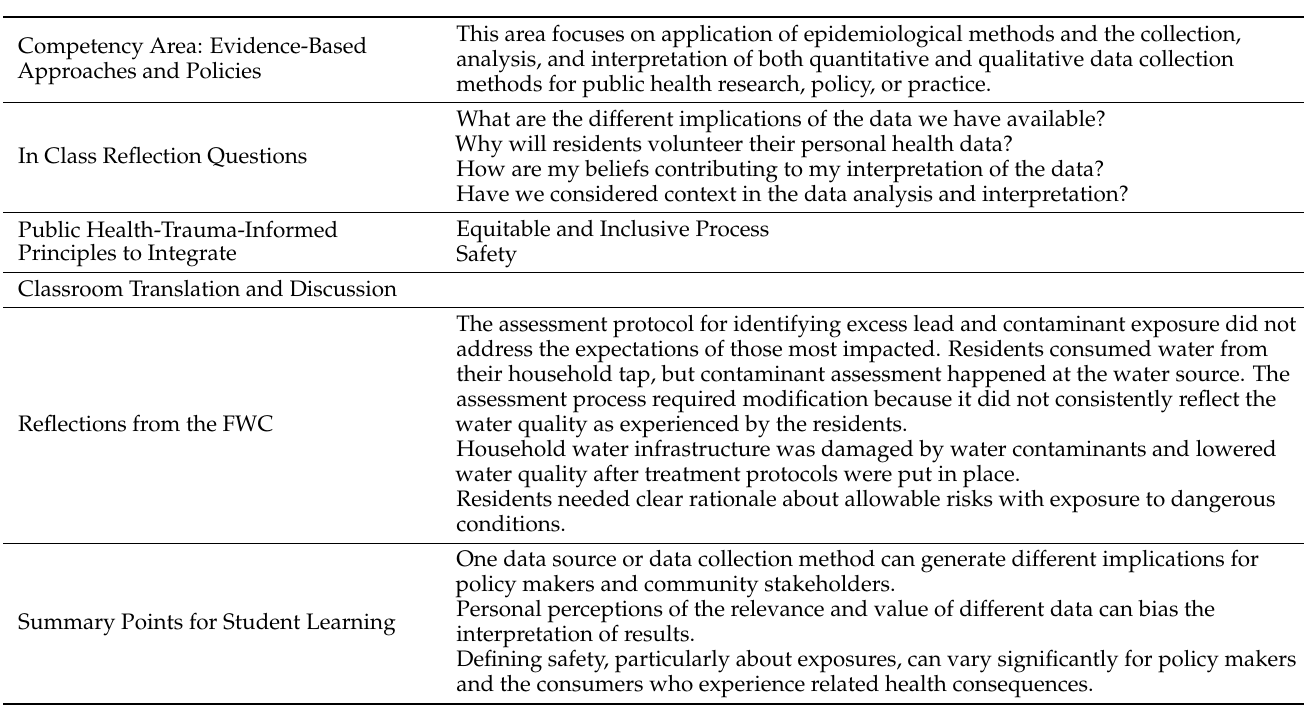
Table 4. Trauma-Informed Principles in Public Health: Addressing Evidence-Based Approaches and Policies in Public Health with Examples from the Flint Water Crisis.